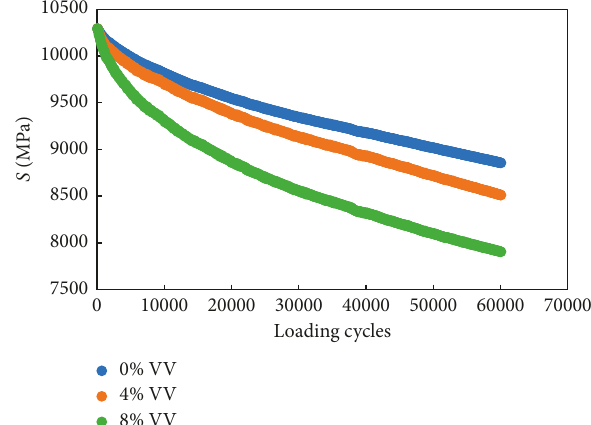
Figure 14: Bending stiffness modulus of virtual asphalt mixture samples with different air void